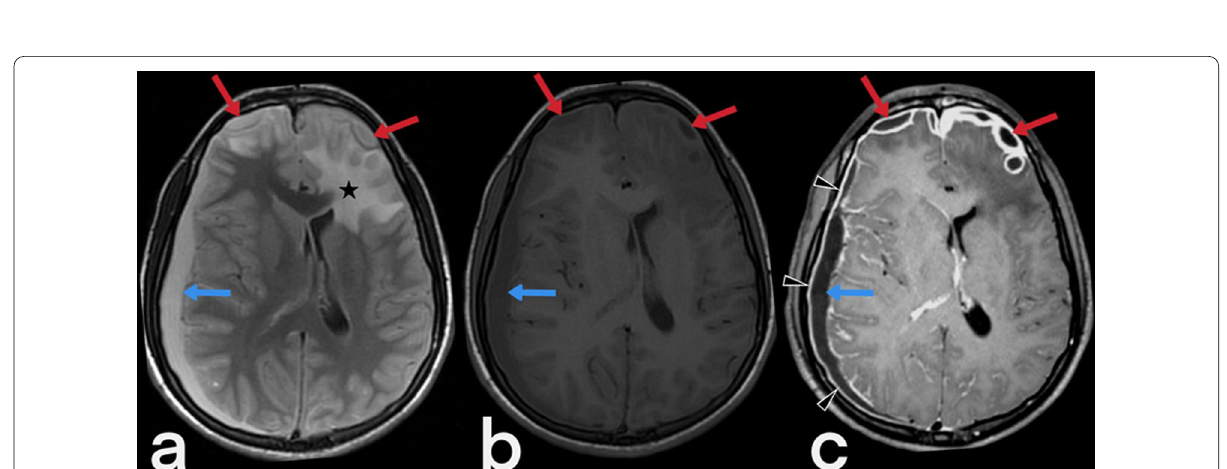
Fig. 2 Axial FLAIR ( a ), pre-contrast ( b ) axial T1 weighted, and post-contrast ( c ) axial T1 weighted MR images of a 21-year-old male. Axial FLAIR image shows high signal intensity caused by edema and inflammation in the left frontal lobe (star). In both anterior frontal regions (red arrows) and right parietal area (blue arrows) are seen subdural abscesses. In addition, MR images demonstrate meningeal enhancement and thickening